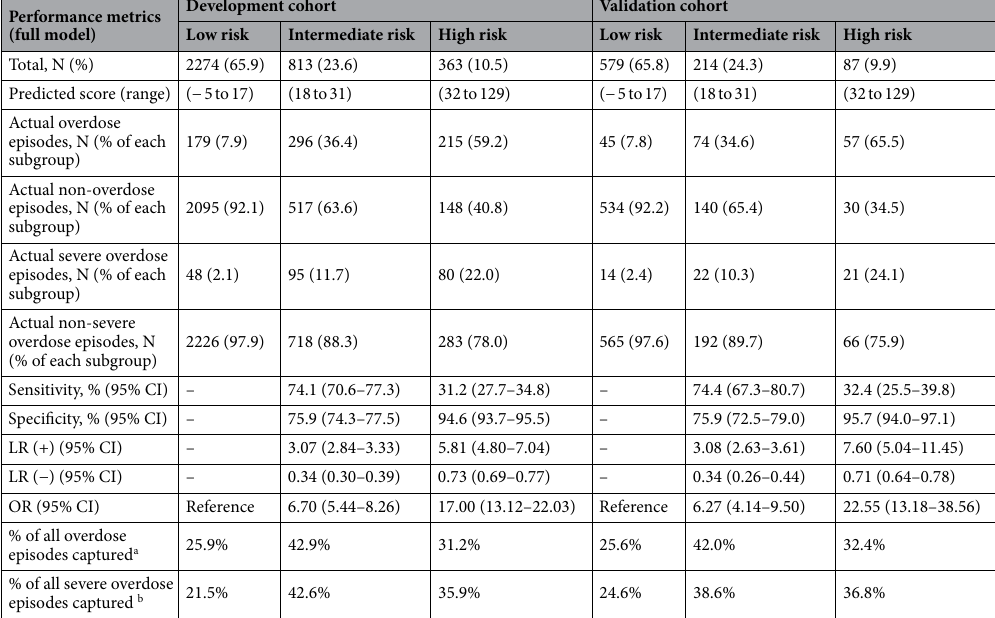
Table 4. Prediction performance stratified by risk. CI confidence interval, LR likelihood ratio, OR odds ratio. a Development cohort: n = 690; validation cohort: n = 176. b Development cohort: n = 223; validation cohort: n =